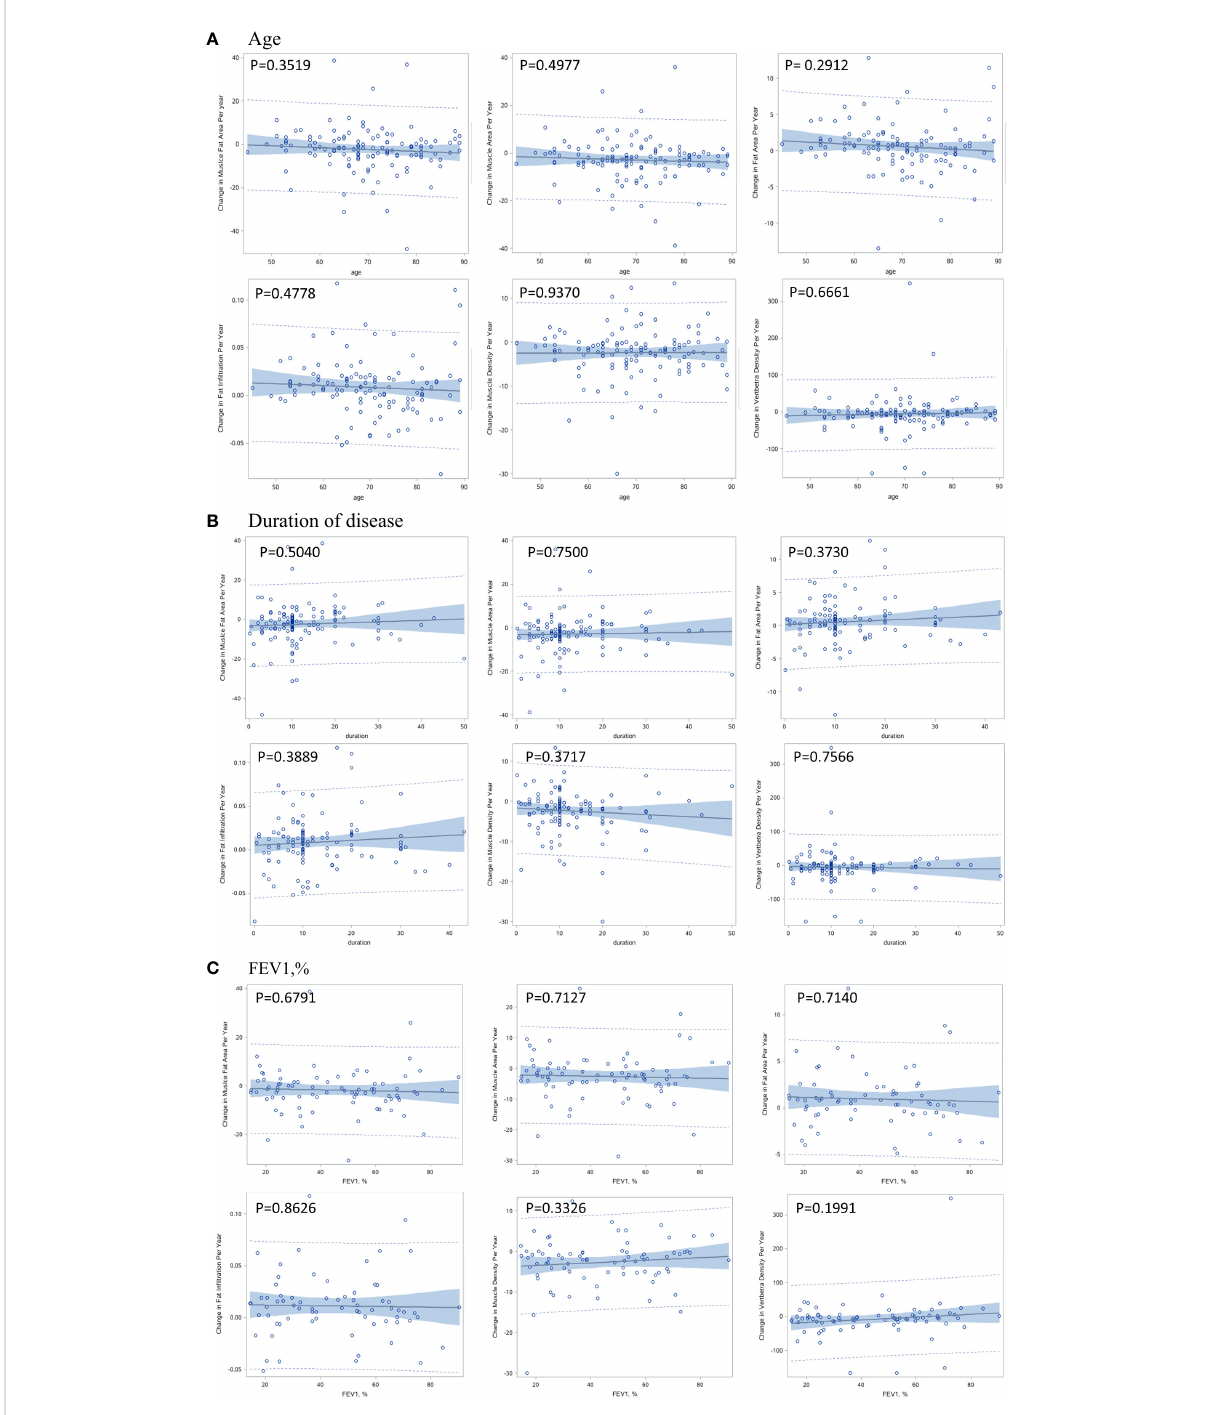
FIGURE 3 Correlation between per-year change in muscle and bone indexes with age (A) , duration of disease (B) , and pulmonary function (C)